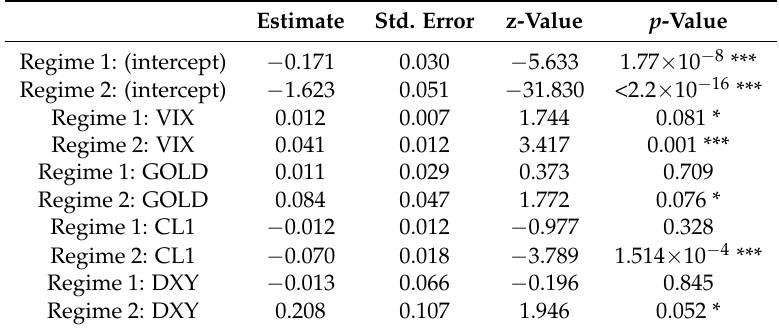
Table 4. Estimated parameters for the multinomial logit models to explain regimes for the S&P 500 index. Regimes are identified by smoothed probabilities based on the estimated 3-regime Markov switching models. ‘***’, ‘**’, and ‘*’ denote significance at the 1%, 5%, and 10% levels, respectively.